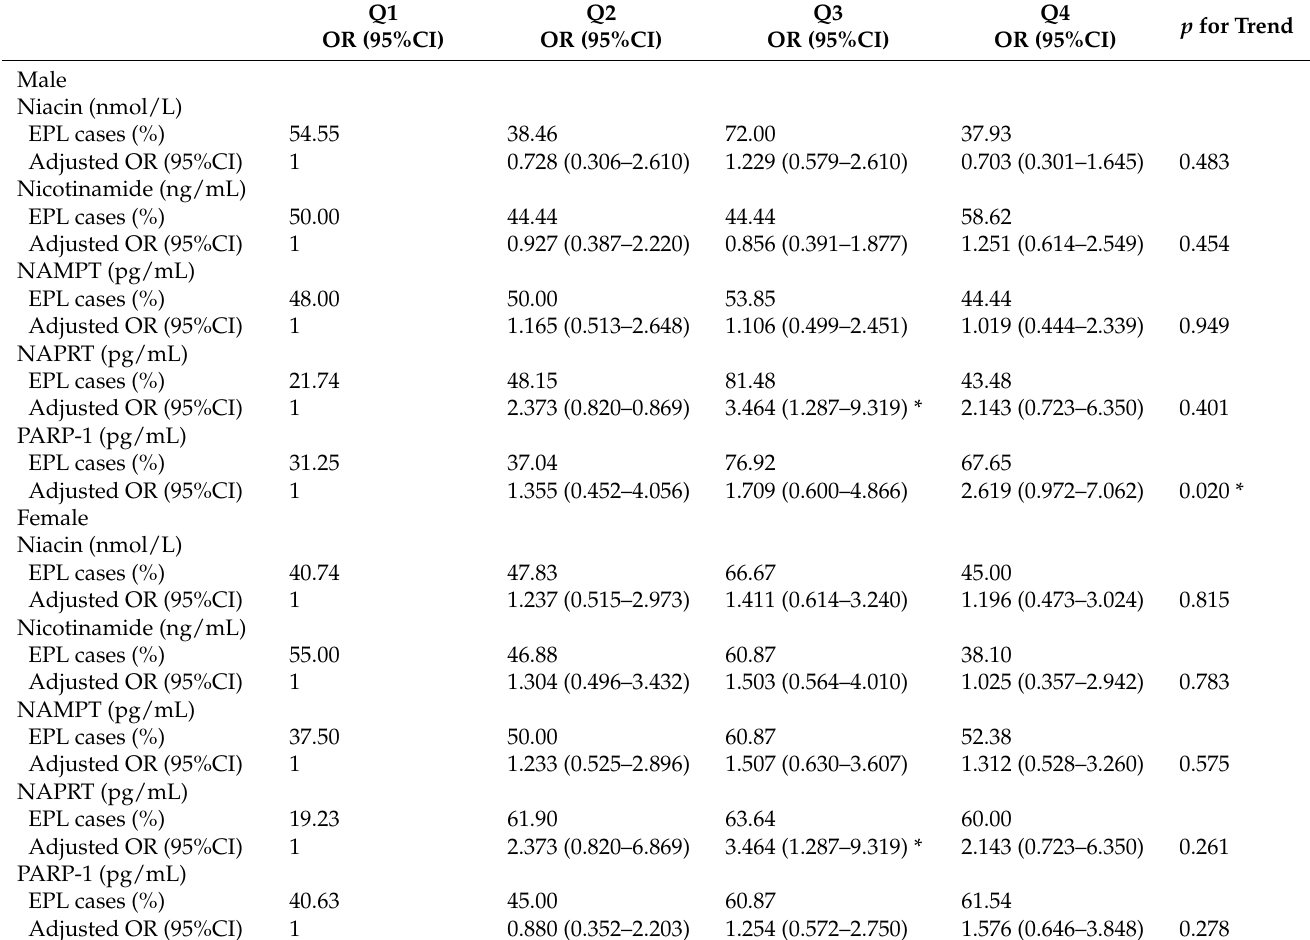
Table 3. ORs (95% CIs) of relevant variables for NAD with EPL in male and female subgroups. Q1